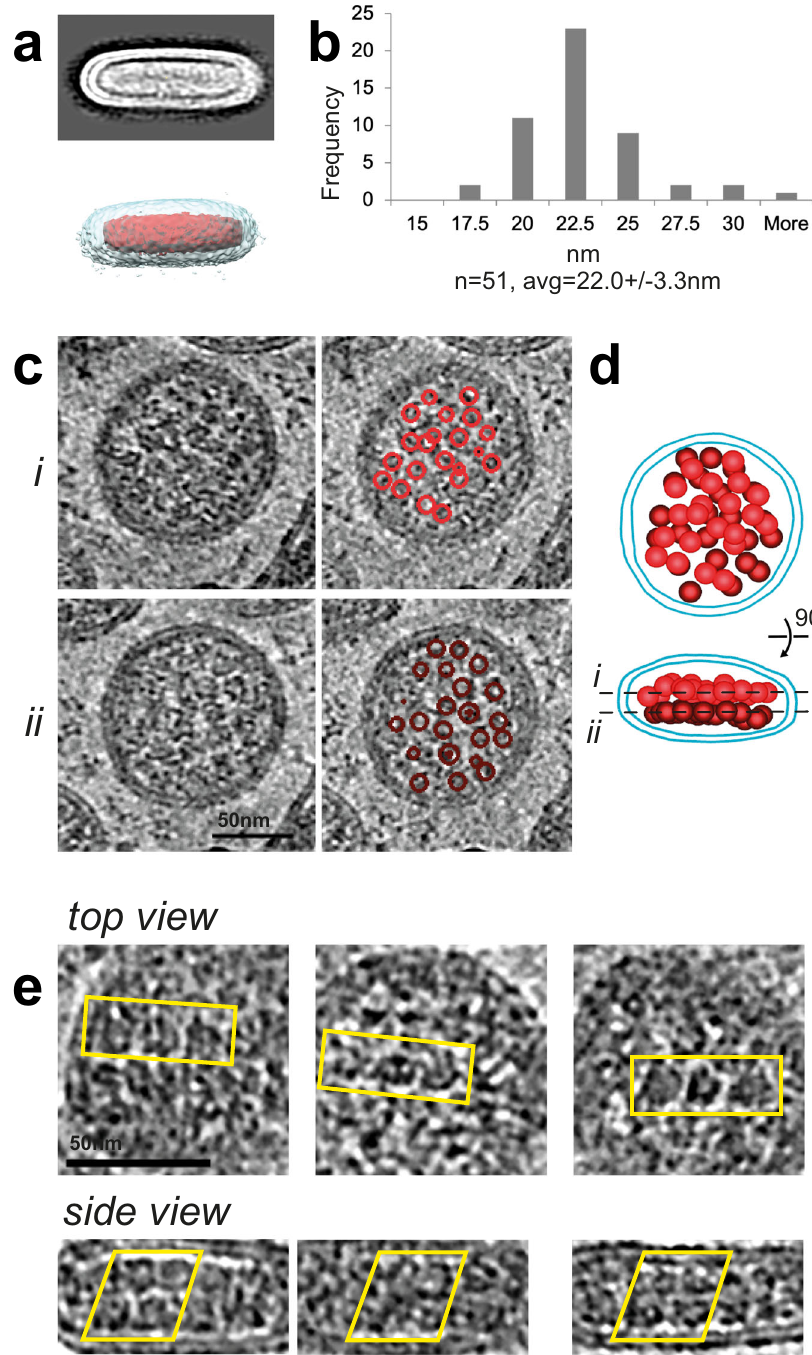
Fig. 3 RNP features in Wuhan SARS-CoV-2 virions. a Average map (top) of n = 268 virions showing membrane bilayer and internal nucleocapsid double layer and map segmentation (bottom) to indicate envelope (pale blue) and nucleocapsid (red). b Histogram of measured height of two layer cylindrical nucleocapsid ( n = 51 nucleocapsids, avg = 22, s.d. 3 nm). c Two tomogram sections through the same virion 12 nm apart (i, ii) and the same sections with spherical RNP subunits identi fi ed by red circles ( i : bright red, ii : dark red). Different subunits are labelled in each section. d Model of virion in c showing bilayer in cyan and RNP subunits as 13 nm red spheres with sections in c indicated by dotted lines. 45 RNP subunits are shown in this virion which is at the top end of size range. e High magni fi cation gallery of virions showing top circular and side views identifying arrays of RNP subunits (outlined in yellow boxes). The side views show a staggered and inter-digitated packing of RNP